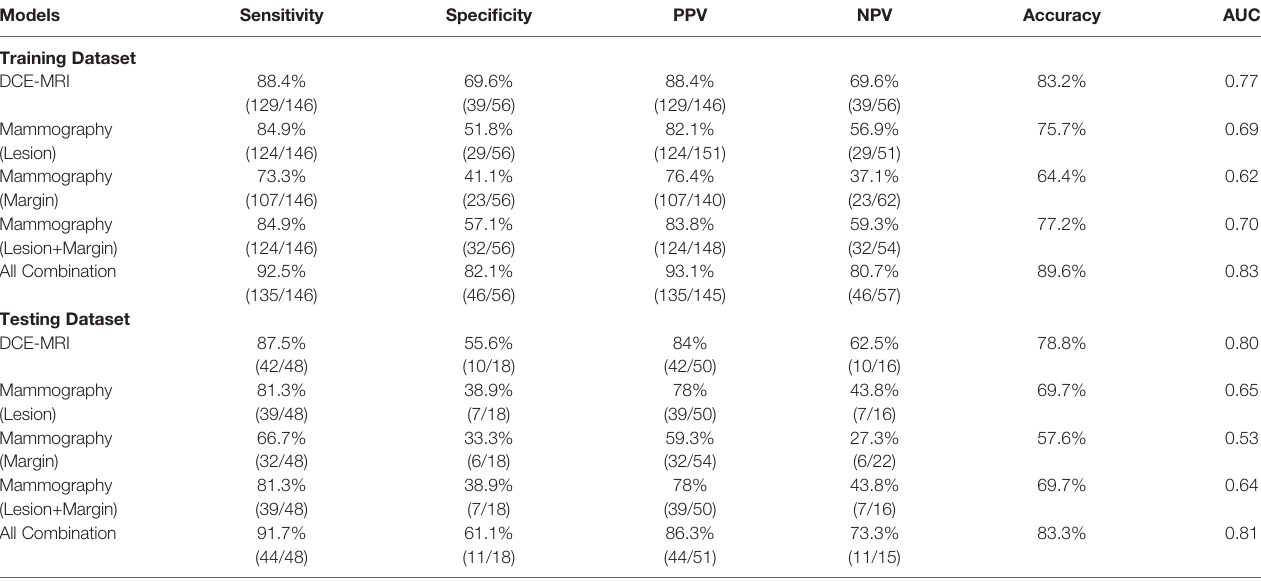
TABLE 3 | The diagnostic performance of developed radiomics models in training and testing datasets.